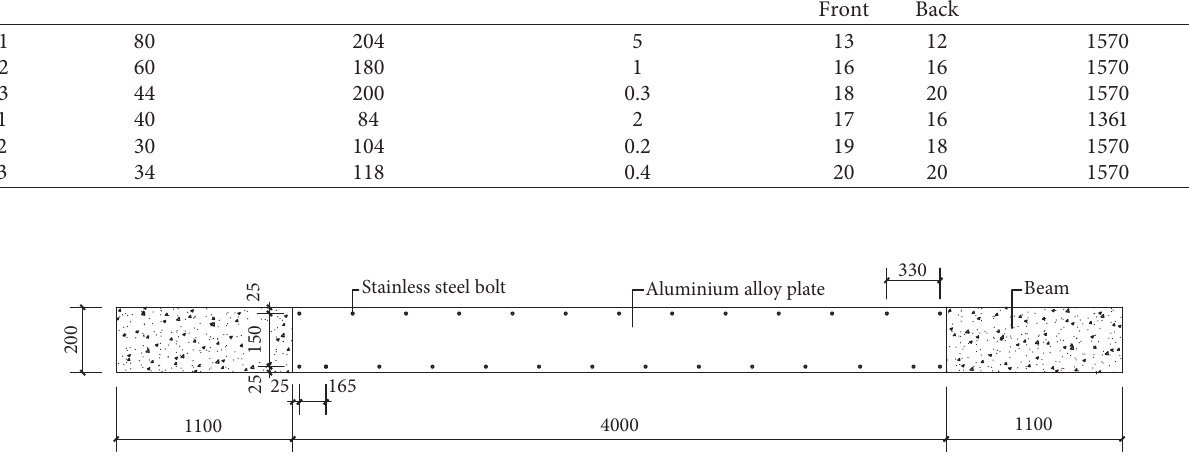
Figure 2: The detailed description of bolts and AA plate.